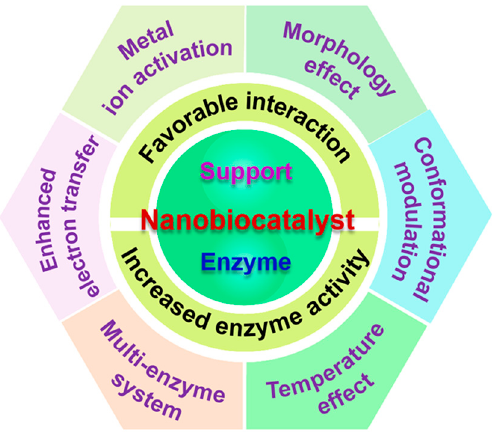
Figure 1. Design of nanobiocatalysts with favorable interactions between enzymes and nanostructured supports for enhanced activities. Table 1. Recent nanobiocatalysts with increased activities, constructed by various nanostructure supports and enzymes.